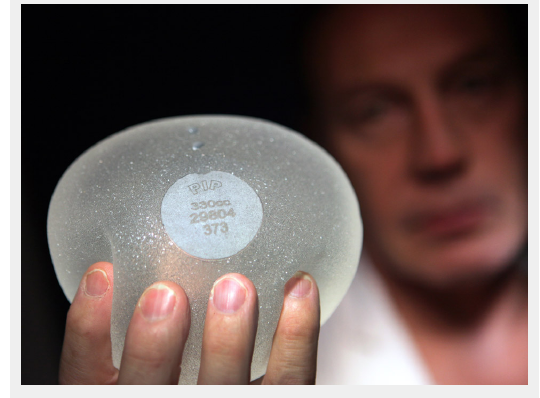
Silicone gel filled silicone rubber breast implant, manufactured by the French company Poly Implant Prosthese (PIP). © Sébastien Nogier / AFP. Reprinted with